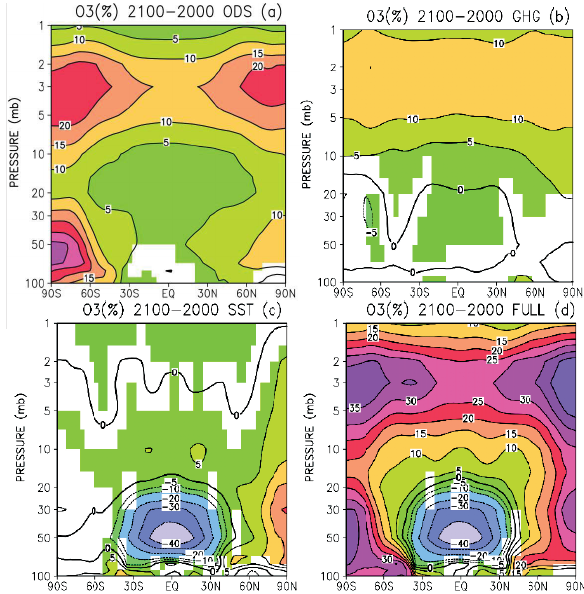
Fig. 3. Zonal, annual and ensemble mean changes of the ozone mix- ing ratio (%) from 2000 to 2100 caused by (a) ODS; (b) GHG; (c) SST/SI; (d) all factors (ODS, GHG, and SST/SI). Color pat- tern indicates the regions where the changes are judged statistically significant at or better than 5% level. Positive changes are shown in reddish colors while small or negative changes are colored in blue/violet.